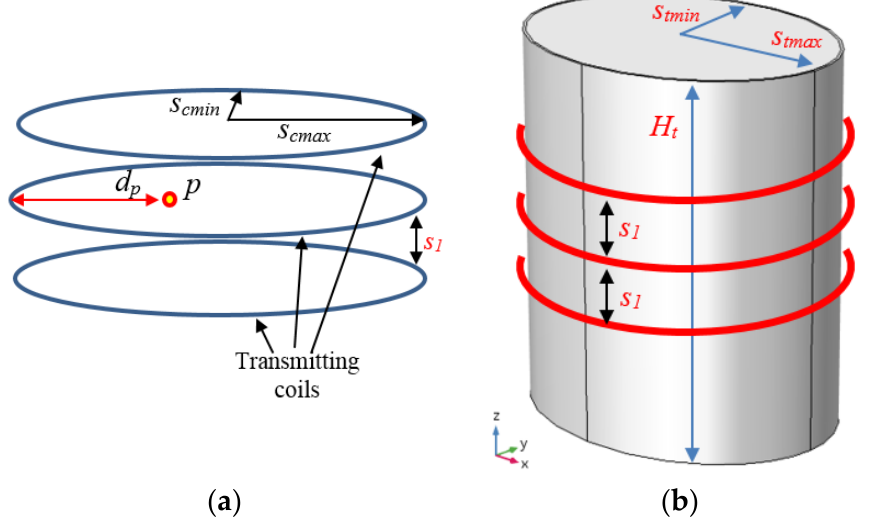
Figure 5. ( a ) Primary-coil geometry for N 1 = 3. ( b ) Simplified torso configuration with primary coil.